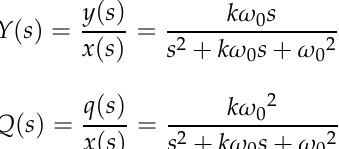
Figure 4. Basic structure of the second-order generalized integrator.